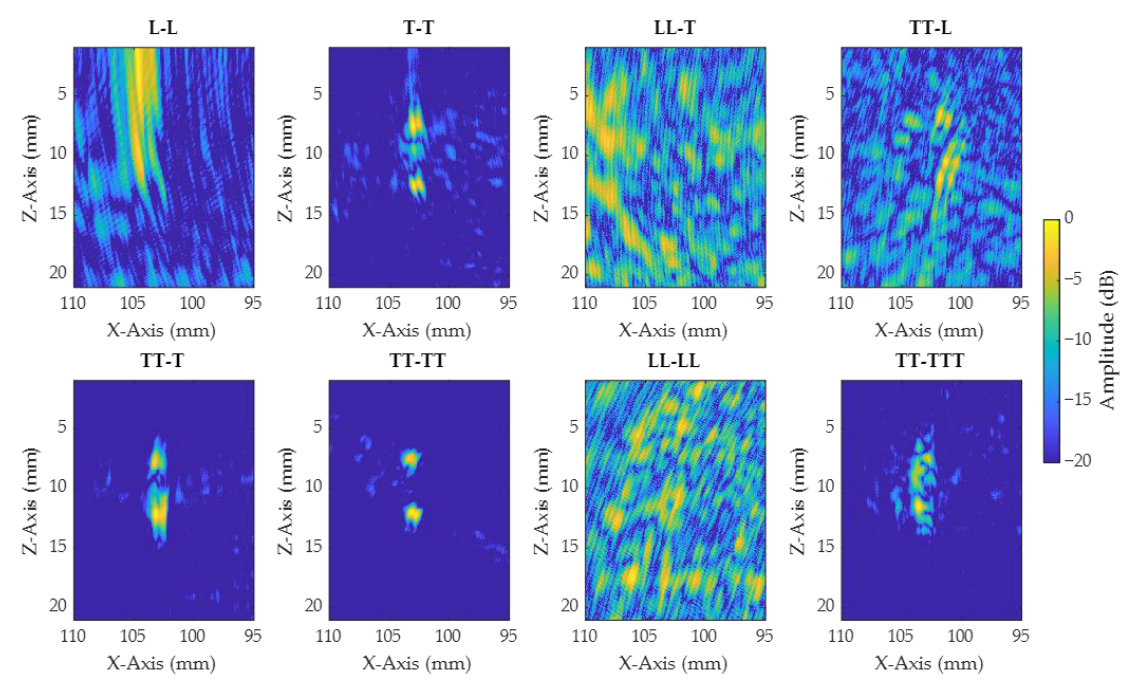
Figure 11. IPCI imaging algorithm applied to different views for notch A. The X -axis corresponds to the lateral distance from the wedge and the Z -axis to the vertical distance in the sample.